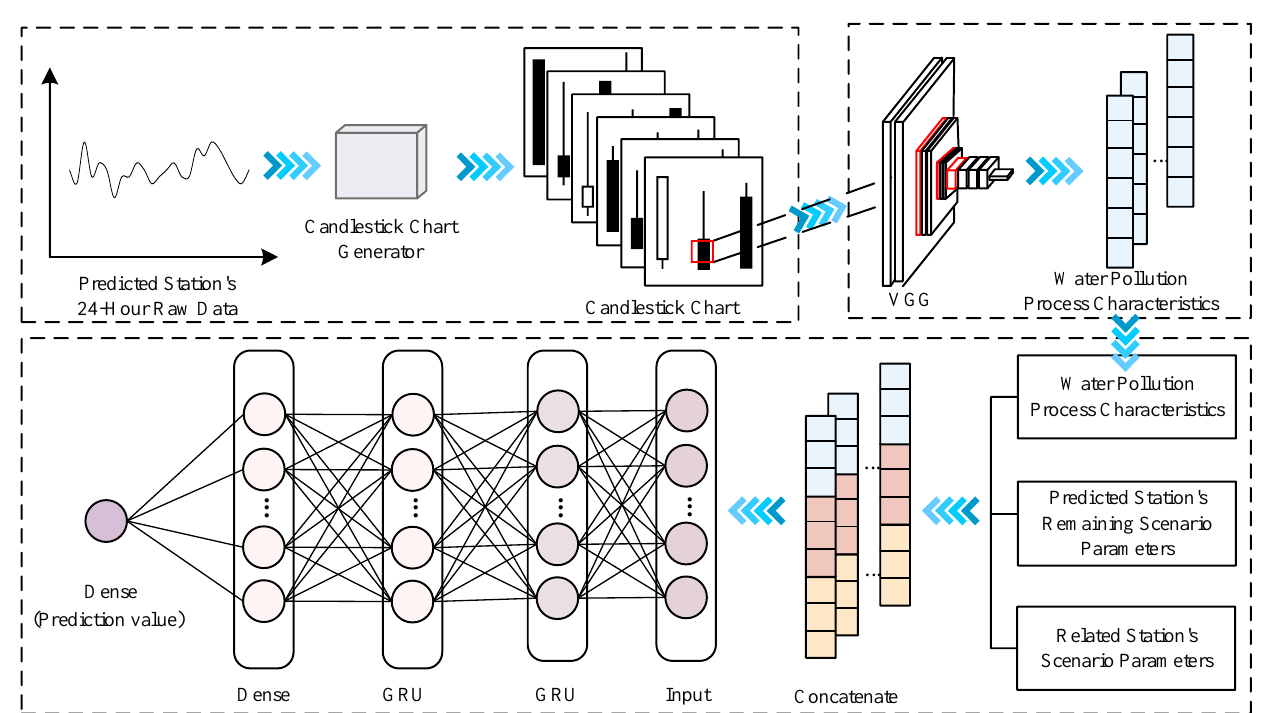
Figure 6. Architecture of the CT-VGG-GRU model.